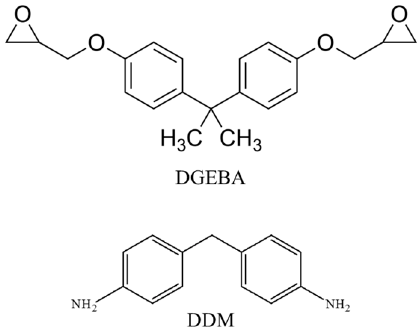
Figure 1. Chemical structures of DGEBA and DDM.